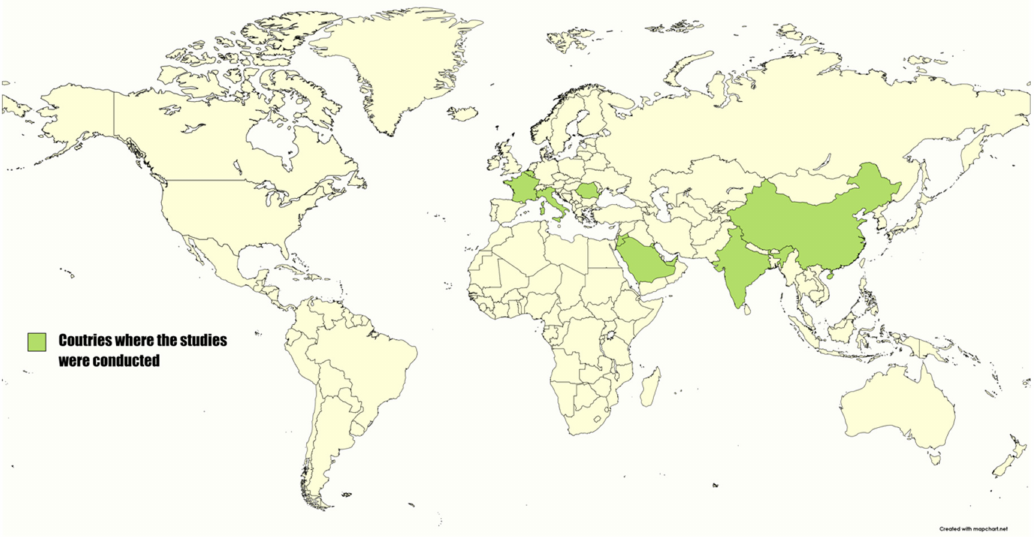
Figure 1. Geographic situation of the countries concerned by MPOX